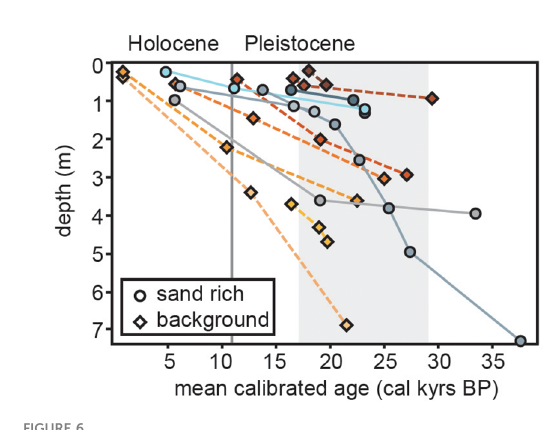
FIGURE 6 Plot of mean calibrated radiocarbon ages versus sample depth. A regression of all ages results in an average sedimentation rate of 19 cm/ky. Gray rectangle indicates approximate timing of the Last Glacial Maximum.